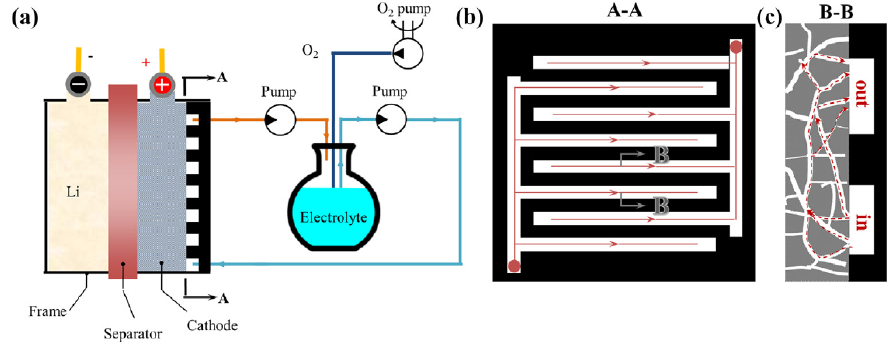
Figure 33. ( a ) An active Li-oxygen battery system; ( b ) interdigital channel at the cathode; and ( c ) cross-sectional view of interdigital channels. Republished from Li et al. [46], with permission of The Electrochemical Society conveyed through Copyright Clearance Center, Inc.